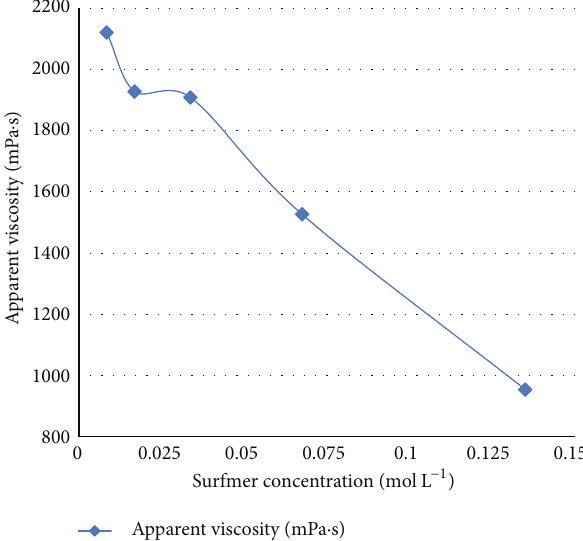
Figure 10: Effect of surfmer concentration on apparent viscosity.